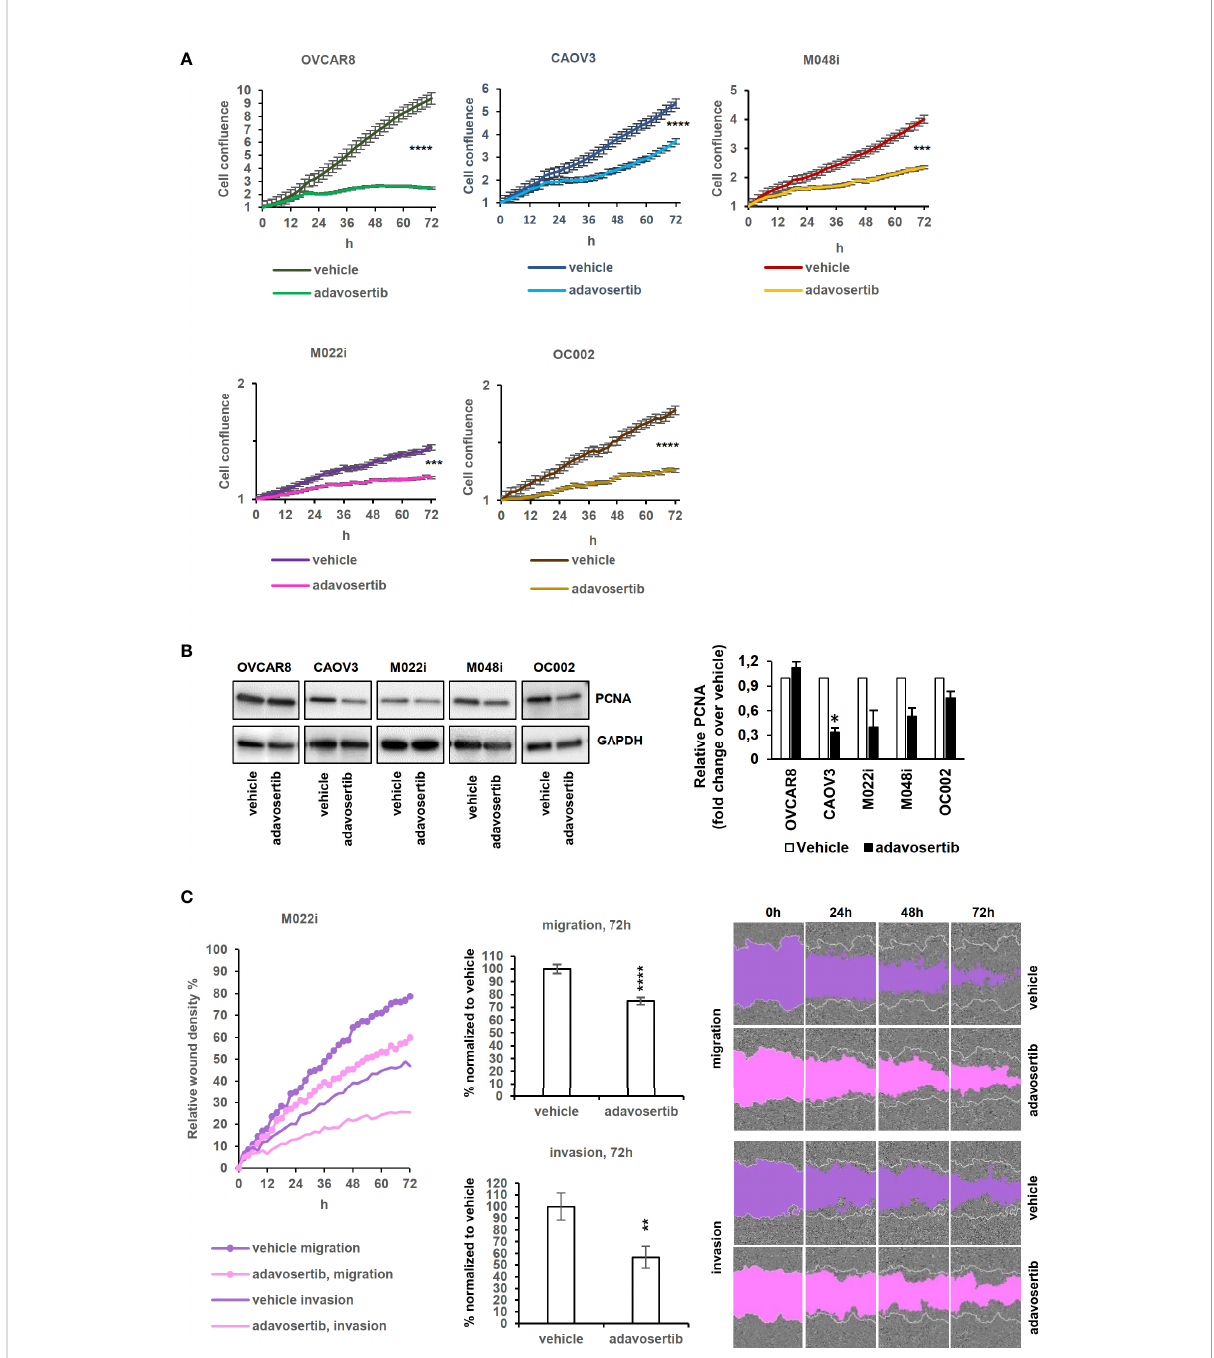
FIGURE 4 Effects of adavosertib on proliferation and wound healing. (A) Proliferation of HGSOC cells treated with adavosertib (500 nM) or vehicle was monitored in IncuCyte every 2 h for 72 h (normalized to time point 0 h). (B) Expression of the proliferation marker PCNA (proliferating cell nuclear antigen) protein at 72 (h) The bars show quantitative analysis of PCNA normalized to GAPDH using ImageJ software. The values shown are the mean ± SE of three separate experiments. (C) Wound healing experiment of the M022i HGSOC primary cells treated with adavosertib (500 nM) for 72 (h) Data of the four other HGSOC cells (M048i, OC002, OVCAR8, and CAOV3) are presented in Figure S8. Signi fi cant difference between vehicle and adavosertib treatment was determined by the t -test at ns = p > 0.05, *p ≤ 0.05,**p ≤ 0.01, ***p ≤ 0.001, and ****p ≤